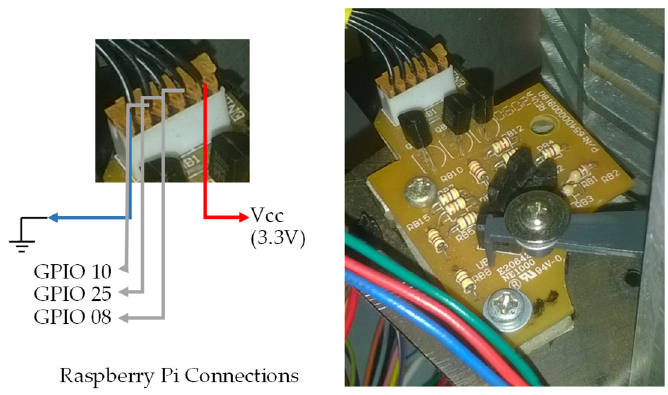
Figure 28. Measuring the spine board and the electrical reference connections.